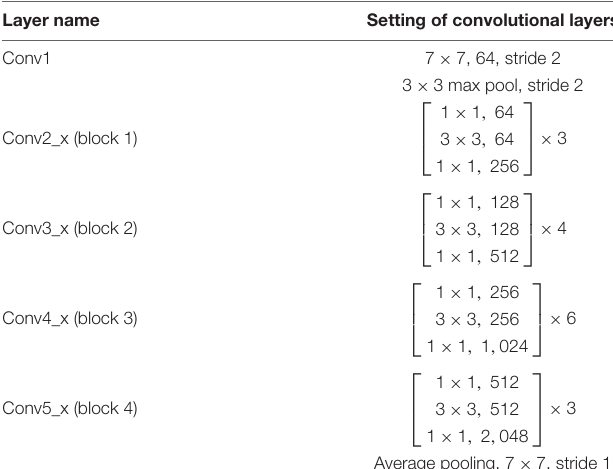
TABLE 2 | Description of standard